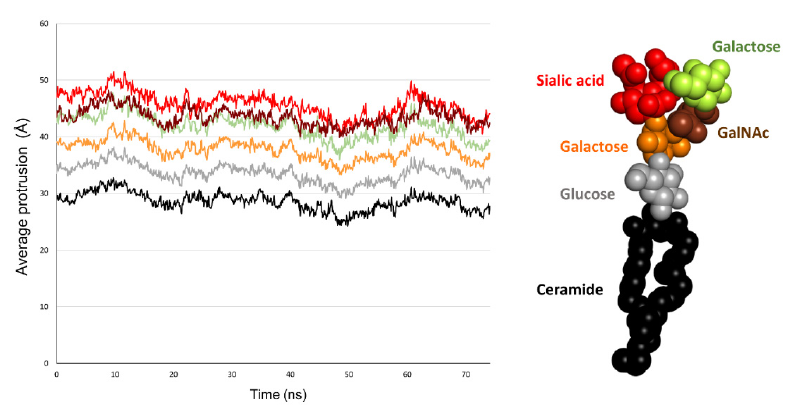
Figure 3. Plot showing the average of maximum value over the time along the z-axis for the ceramide part of GM1 molecules (black), glucose residues (grey), galactose residues (yellow), β GalNAc residues (brown), and sialic acids residues (red).